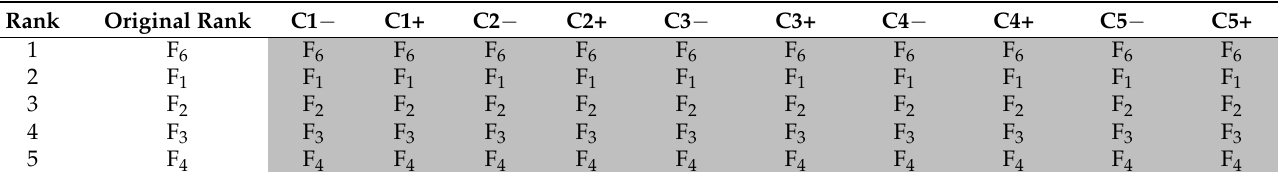
Table 23. Sensitivity analysis results for the criteria—the factors’